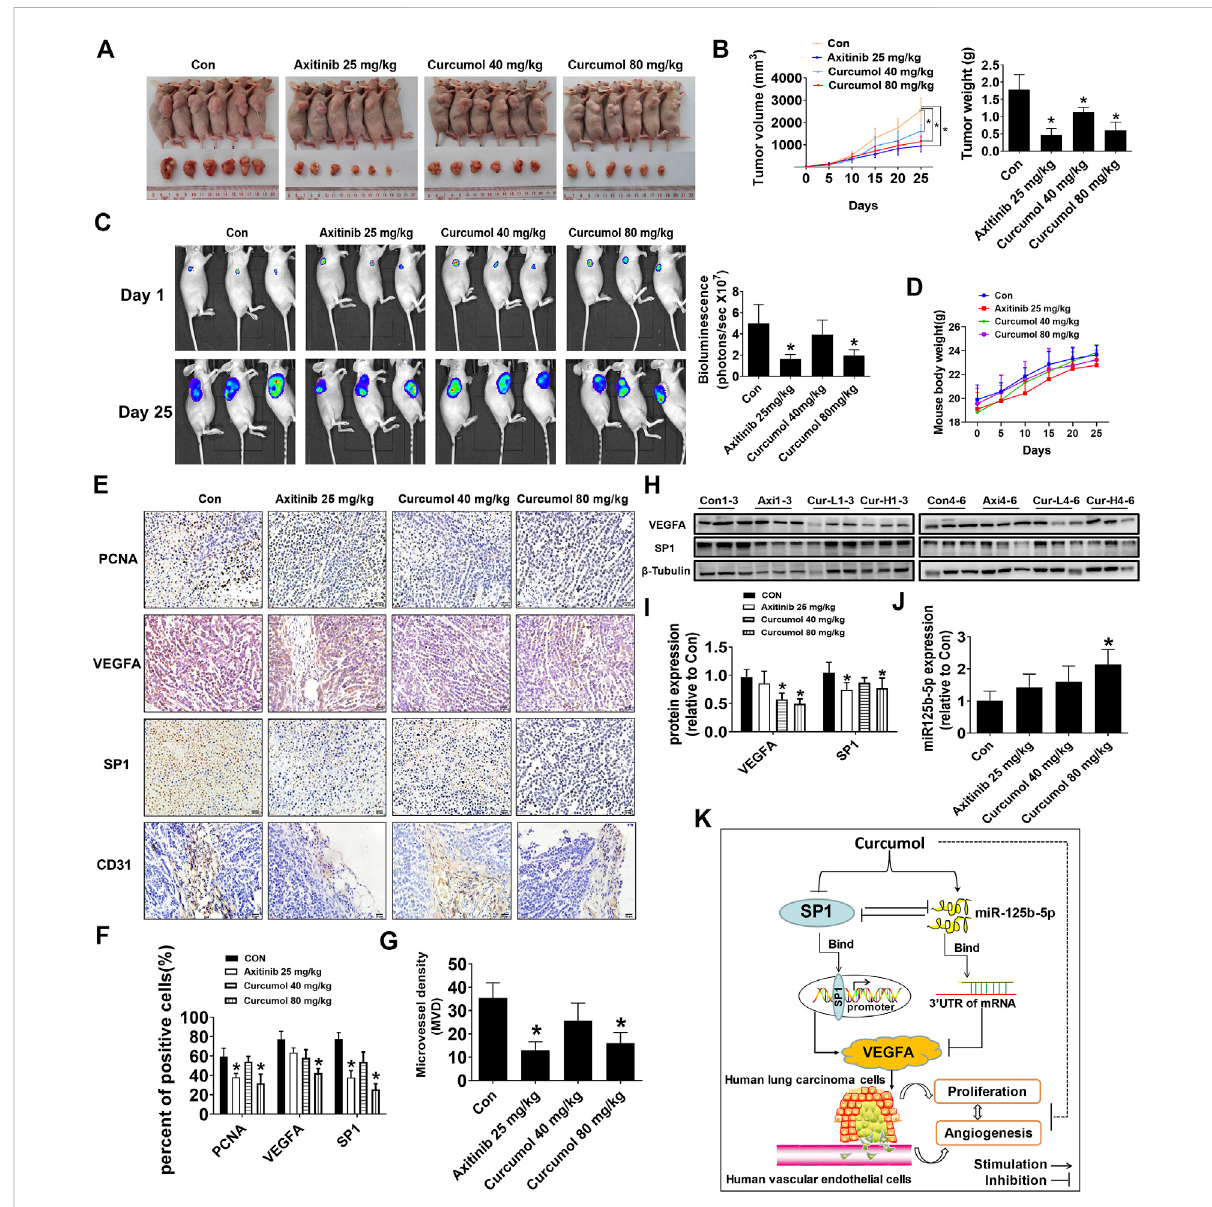
FIGURE 6 Curcumol reduced tumor burden and MVD of nude mice. (A , B) Mice (n = 6 per group) were divided into four groups (Con [saline], Axitinib [25 mg/kg], Curcumol [40 mg/kg], and Curcumol [80 mg/kg]). Tumor tissue were harvested and photographed after 25 days intragastric administration.Tumorvolumeand tumor weight weremeasured. (C) Tumorgrowth degree wasevaluated bymeasuring bioluminescencesignals in IVIS imaging system on1st dayand 25thday. (D) Body weight ofmice ineach grouprecordedevery 5 days. (E – G) Immunohistochemistry(IHC) images of PCNA, VEGFA, SP1, CD31. Scale bar, 20 μ m. ImageJ software was used to count positive cells. Microvessel density (MVD) was calculated through CD31 antibody staining. (H , I) VEGFA and SP1 protein expression level in mice fresh tumor tissue were detected by Western blot. Axi,